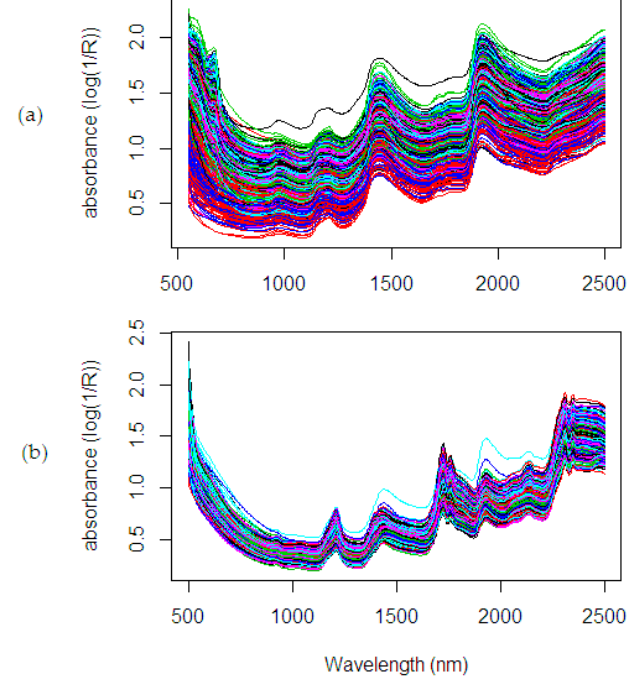
Figure 5. NIR spectra on oil palm fruit mesocarp: ( a ) fresh mesocarp, ( b ) dried ground mesocarp.